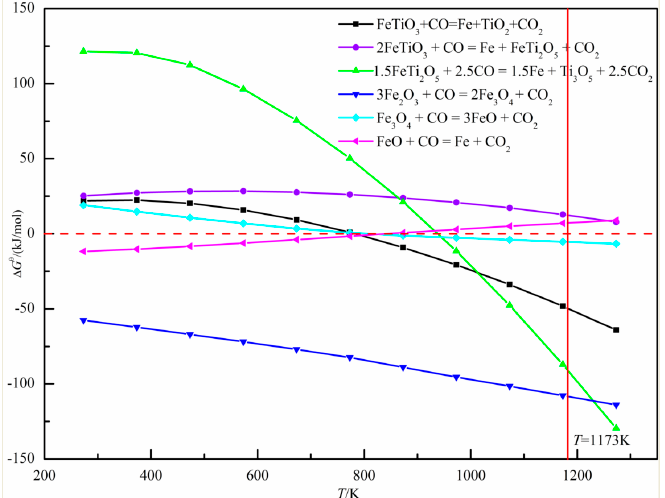
Figure 17. Relationship between Δ G θ and T in the reduction process of oxidized pellets with the sea sand ore.